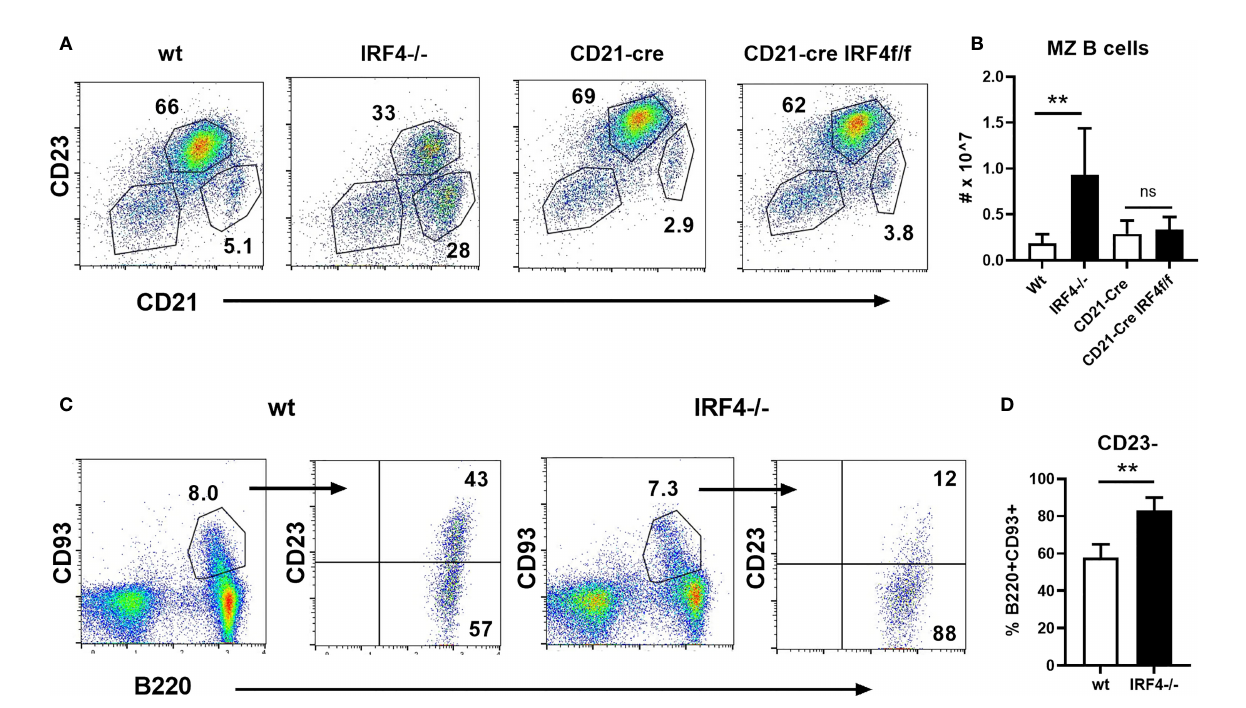
FIGURE 3 | Normal MZ B cell numbers in CD21-cre.IRF4f/f mice. (A, B) Splenocytes from wild type, IRF4-de fi cient, CD21-cre, and CD21-cre.IRF4f/f mice were stained with antibodies against B220, CD21, and CD23. (A) The frequency offollicular (CD21+CD23+) and MZ (CD21hiCD23lo/-) in the B220+ gate is shown. (B) The total number of MZ B cells gated as in (A) is shown. Data represent mean +/- SD, n = 3-6. **p < 0.01, ns, not signi fi cant by Student ’ s t-test. (C, D) Splenocytes from wild type and IRF4-de fi cient mice were stained with antibodies against B220, CD93, and CD23. Representative fl ow cytometry plots are shown in (C) , while (D) indicates the frequency of B220+CD93+ transitional cells that lack CD23. Data represent mean +/- SD, n = 6. **p < 0.01 by Student ’ s